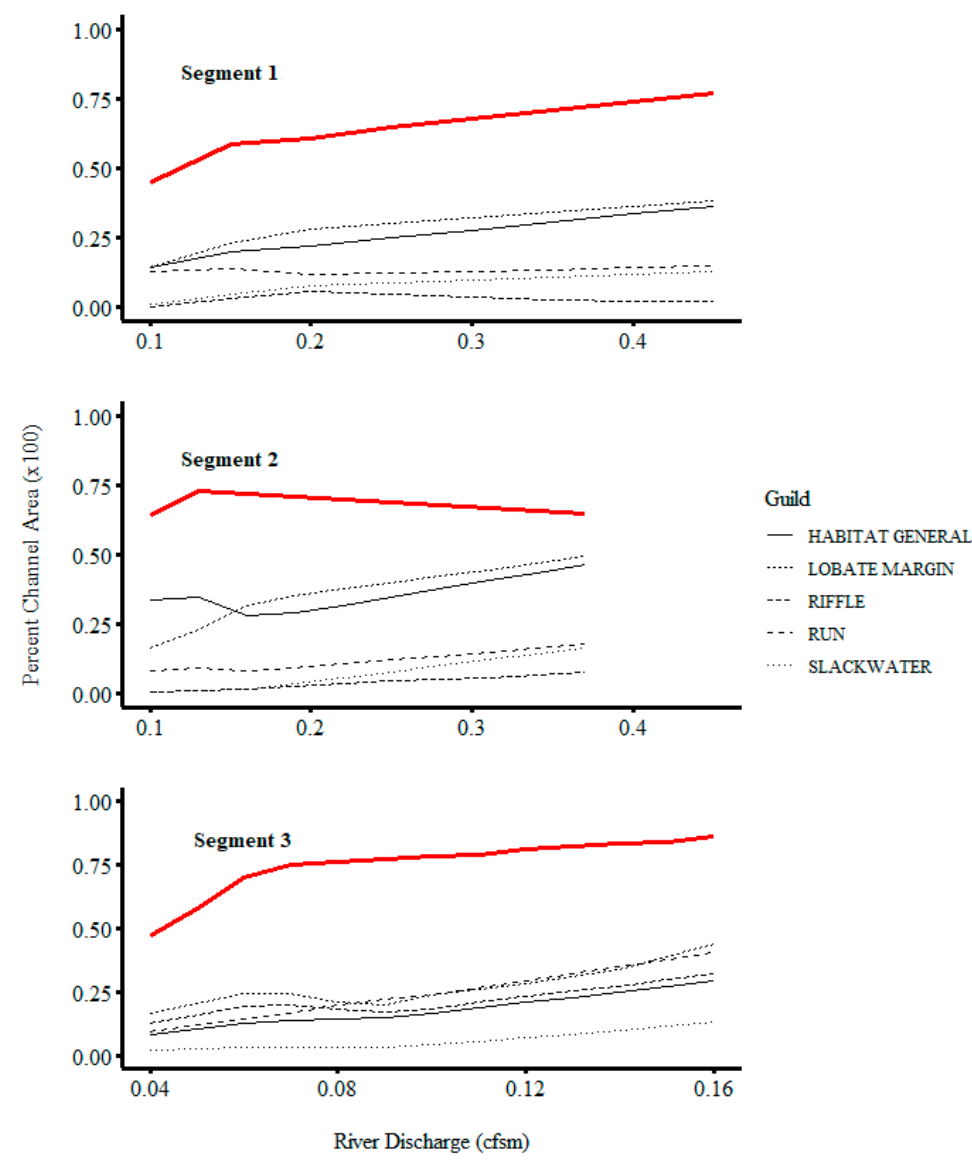
Figure 3. The percent of channel area available to each fish guild across a range of discharges for each river segment of the Niobrara River. The bolded red line is the percentage of the channel area that was considered wetted area. Note different scales used on river discharge axis. Discharge levels are quantified as ft 3 s − 1 mi − 1 (cfsm). Table 3. The percentage composition of the fish community for each guild sampled and the corresponding percentage of suitable habitat available (% channel area, CA) for each guild at three